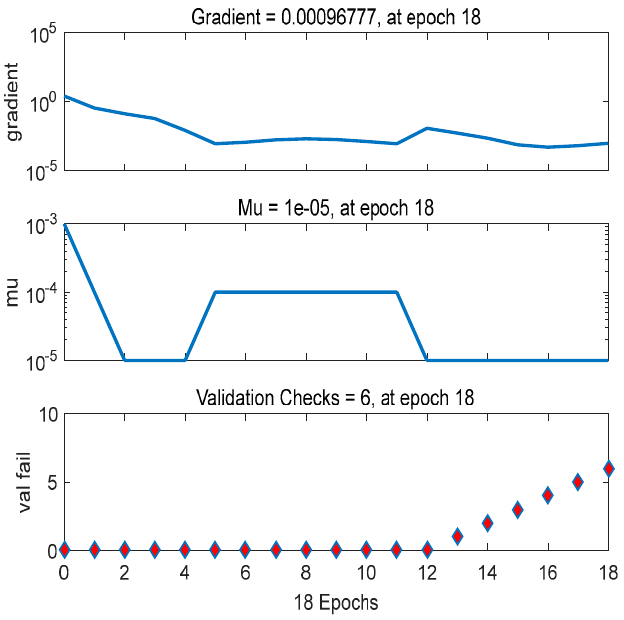
Figure 9. The neural network training state (epoch 18, validation stop).